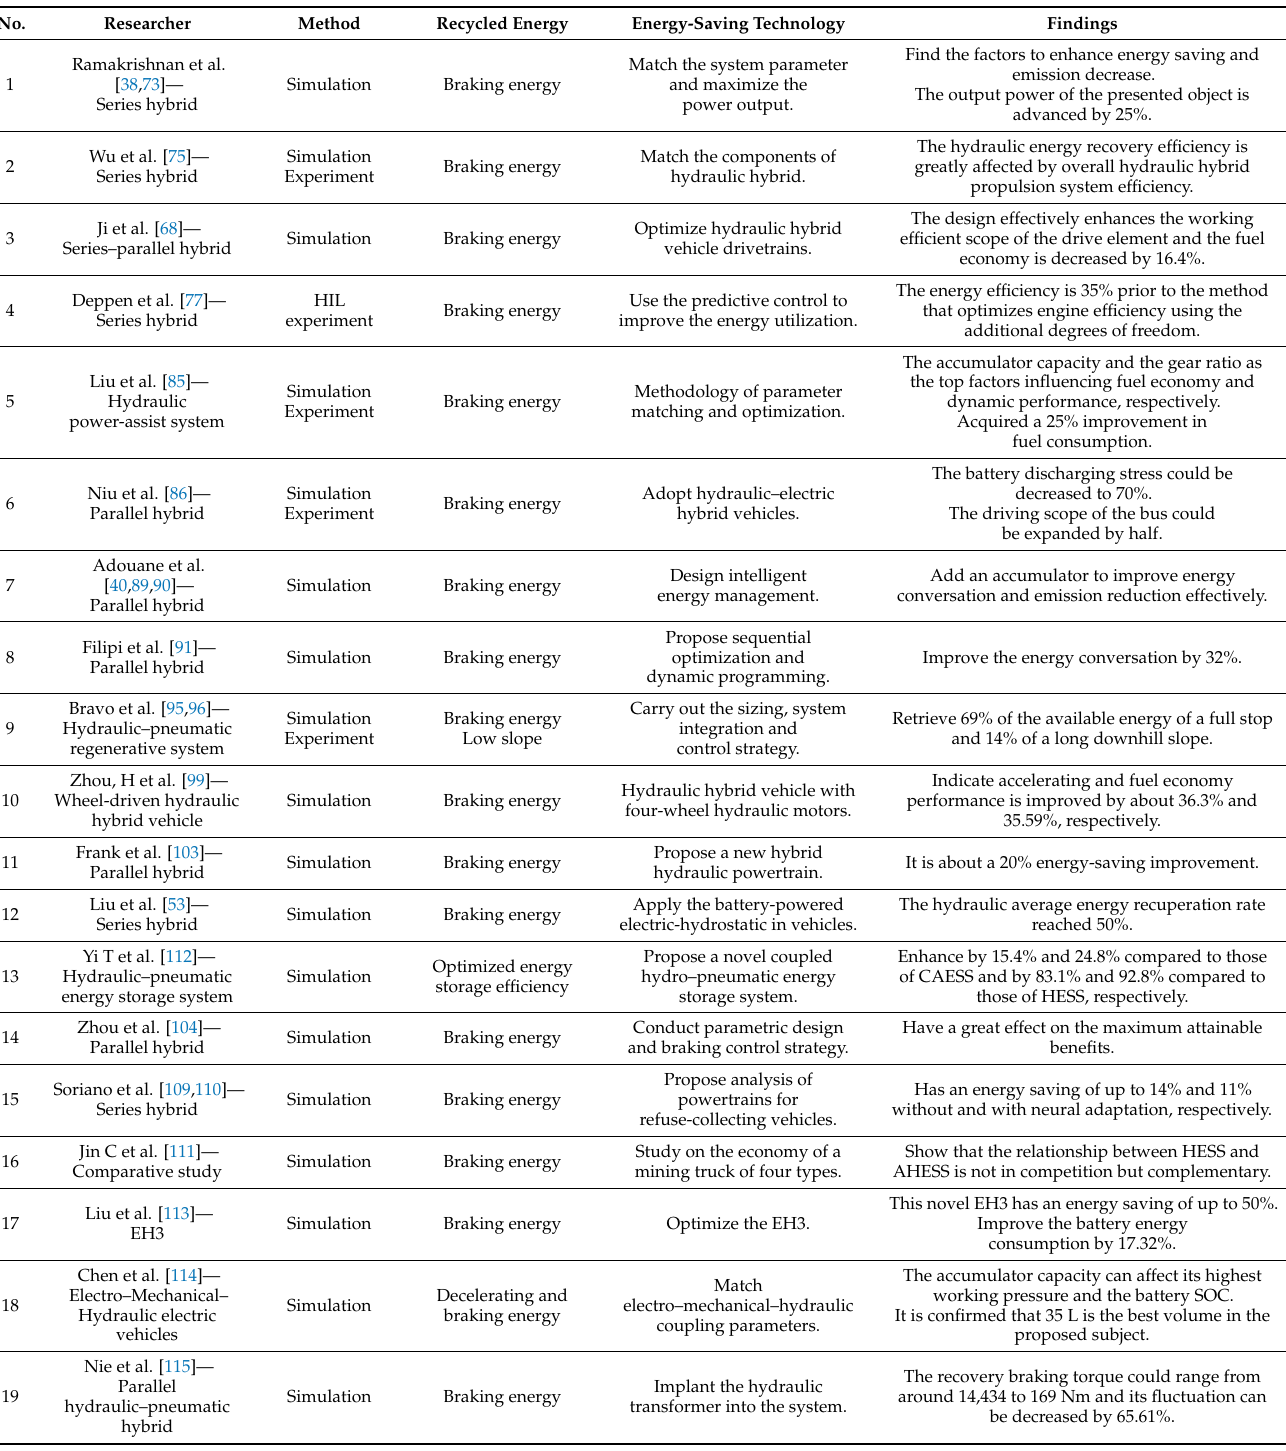
Table 6. Summary of mechanical–electric–hydraulic hybrid energy storage systems in typical